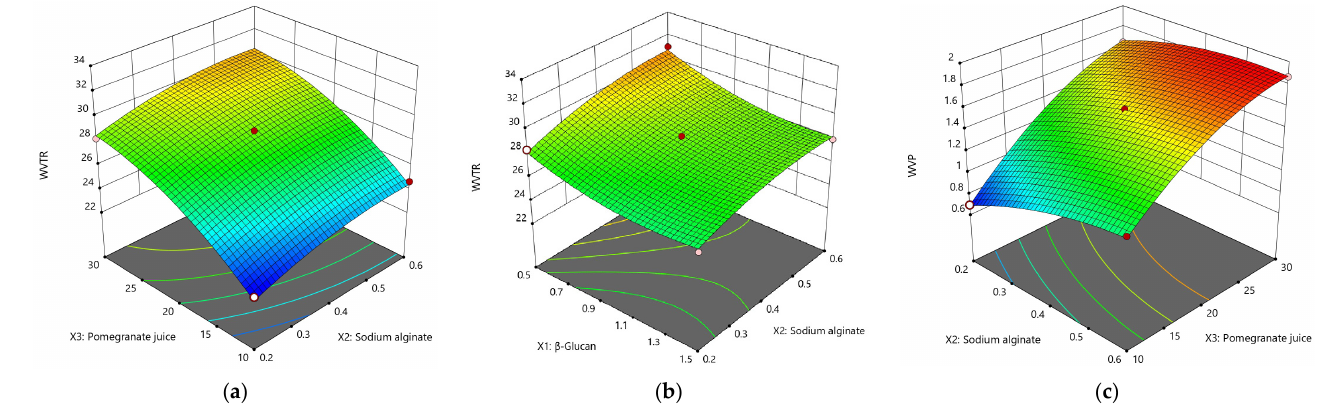
Figure 2. 3-D surface plots for the effect of independent variables on the film WVTR and WVP. ( a